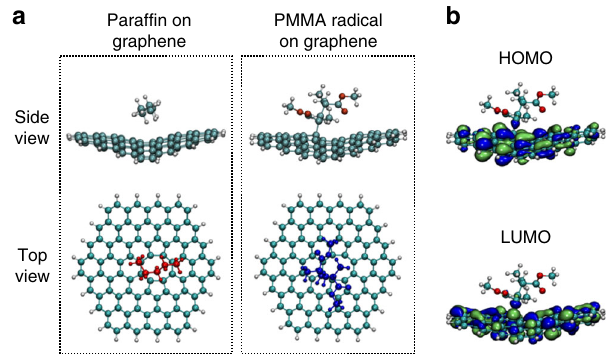
Fig. 6 Adsorption ability of PMMA radical and paraf fi n molecule on graphene. a Adsorption of a paraf fi n molecule and PMMA radical on hexagonal graphene fl akes with hydrogen-functionalized edges and a vacancy defect. Only the PMMA radical formed a covalent bond with the defective graphene fl ake, as veri fi ed by b the shared HOMO and LUMO of the bonded structure. Color code in the side view of a : carbon atoms in dark green, hydrogen atoms in gray, oxygen atoms in red. Color code in the top view of a : paraf fi n in red, PMMA radical in dark blue. Color code in b , the light green corresponds to regions of space where the phase of the wave function is positive, and the blue color corresponds to regions of space where the phase of the wave function is